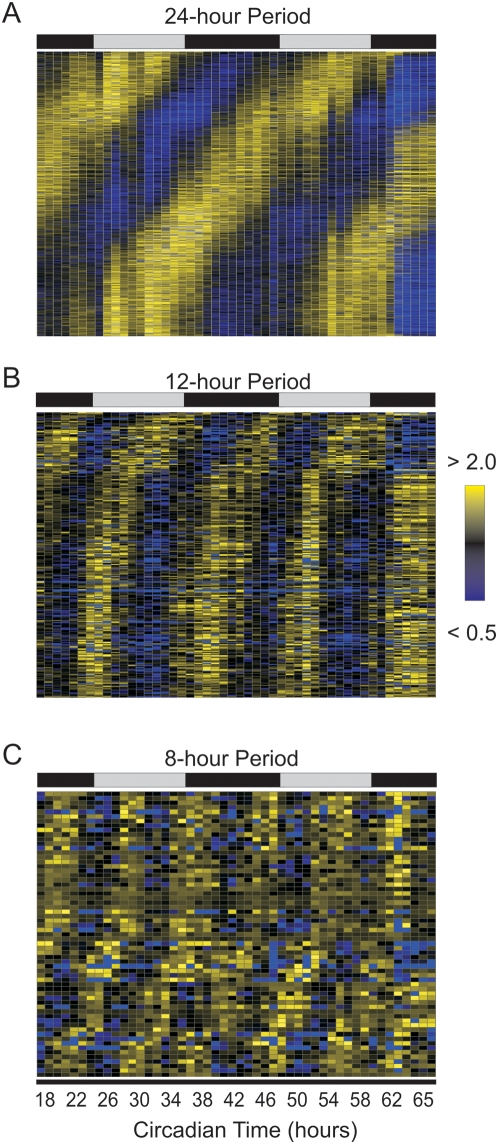
The peaks of 12 h cycling genes correlate with subjective dusk and dawn.Rhythmic transcripts detected by COSOPT and Fisher's G-test at a false-discovery rate of <0.05 were median-normalized and plotted as a heatmap for 24, 12 and 8 h cycling genes (A–C). Bright yellow represents expression 2-fold greater than median levels while bright blue represents expression less than 50 percent of median levels. The time of peak expression of 24 h cycling genes show a roughly equal distribution over the course of a day; in contrast, the peak expression of both 12 h rhythms are biased to specific times each day.